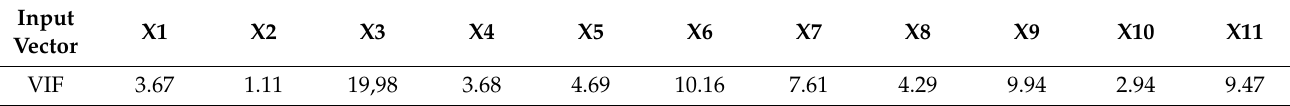
Table 2. VIF value of the input vector.